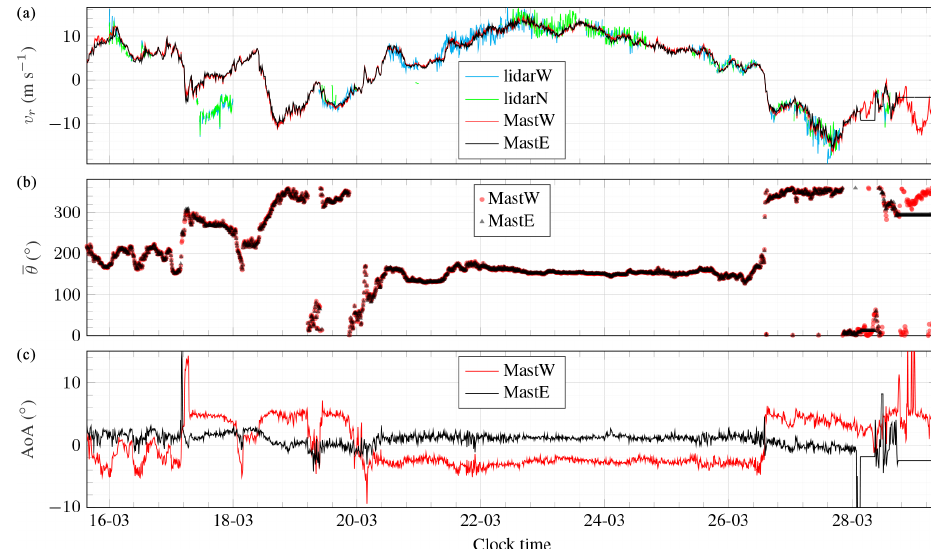
Figure 12. 10min along-beam mean wind speed (a) , mean wind direction θ (b) and mean angle of attack (AoA, c ) recorded from 16 to 29 March 2020 on the northern side of Obrestad Lighthouse.